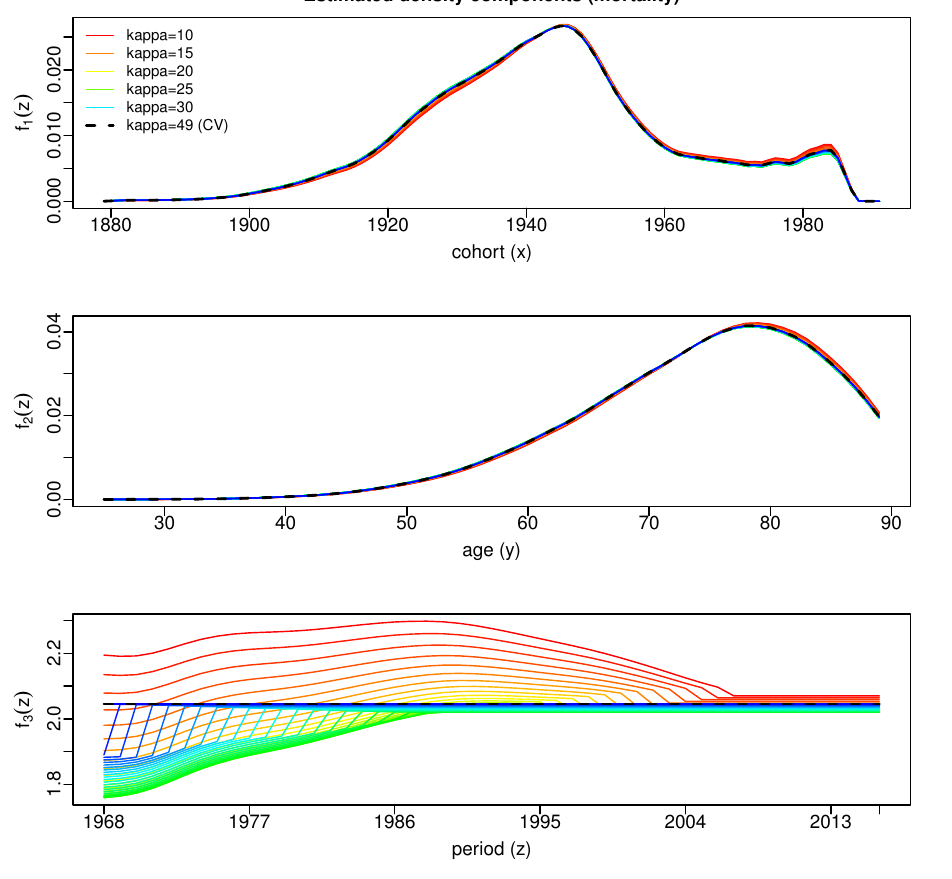
Figure 4. Estimated density components for the mesothelioma mortality data considering different κ values (given in years). The dashed black line shows the estimated density components for the κ = 49 years chosen by